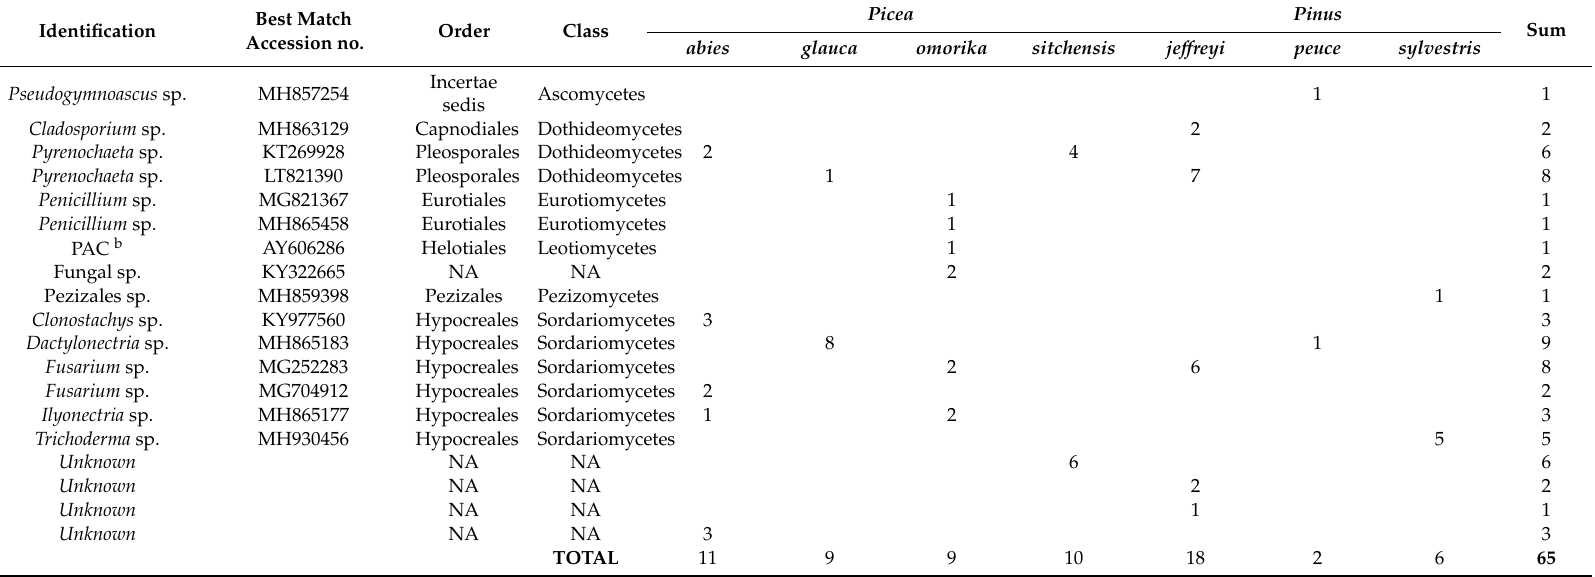
Table 2. The isolated fungal root endophytes’ frequency by tree host